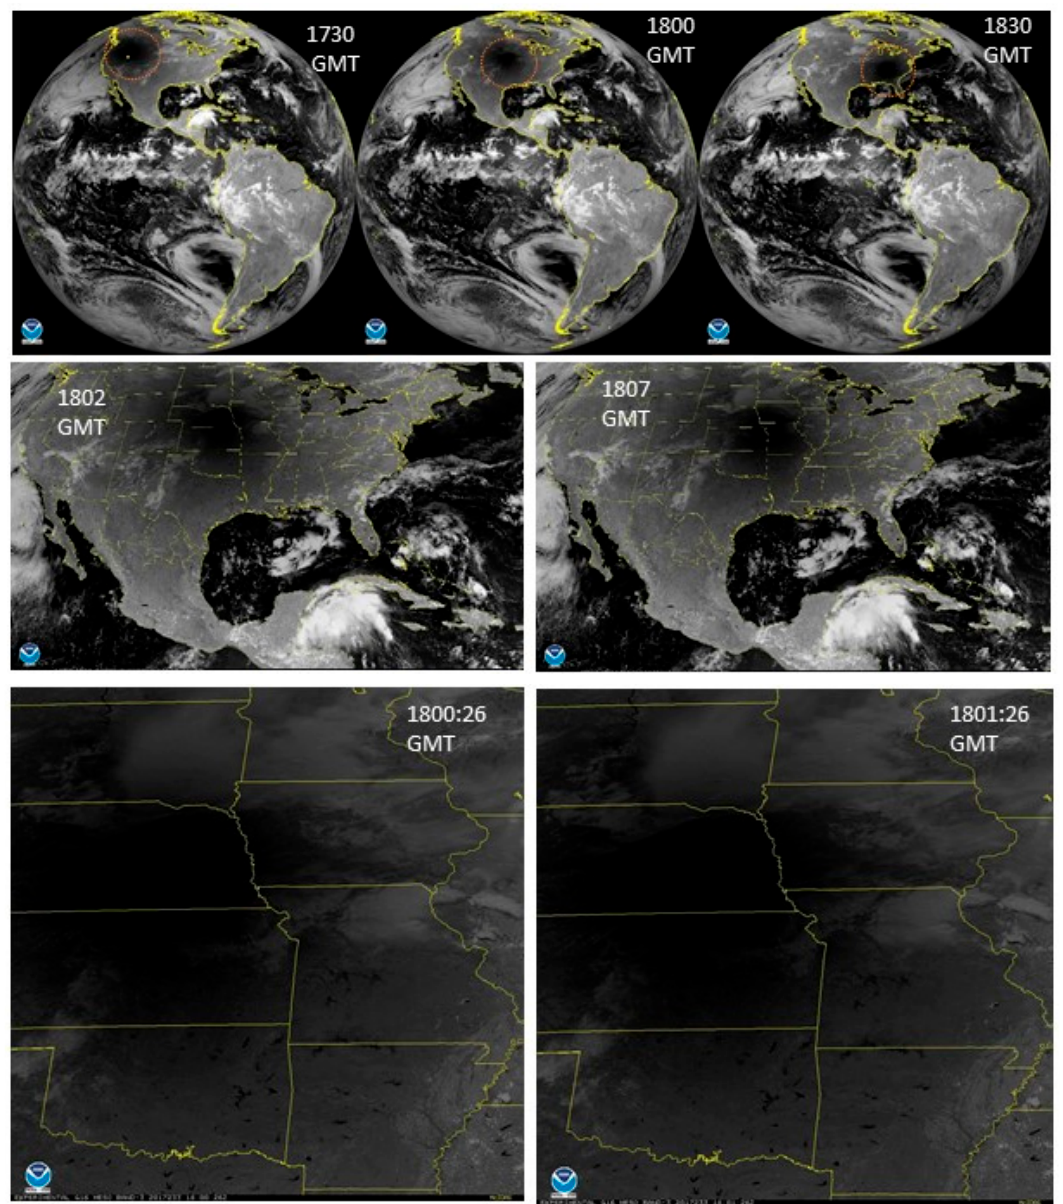
Figure 20. Top panels show images collected by GOES-13 Imager, and the middle and bottom panels show images collected by ABI on GOES-16. The geographic area covering parts of Texas and Oklahoma were extracted from the GOES-13 full disk imagery that is collected every 30 min. ABI collected data every 5 min over the same region. Both GOES-13 and GOES-16 images shown here are created using similar visible (band 1 from Imager and band 2 from ABI) and IR bands (band 4 from Imager and band 13 for ABI) [23]. The IR data have been color enhanced based on brightness temperature (in °C) and made partially transparent so that information from the visible can also be seen.